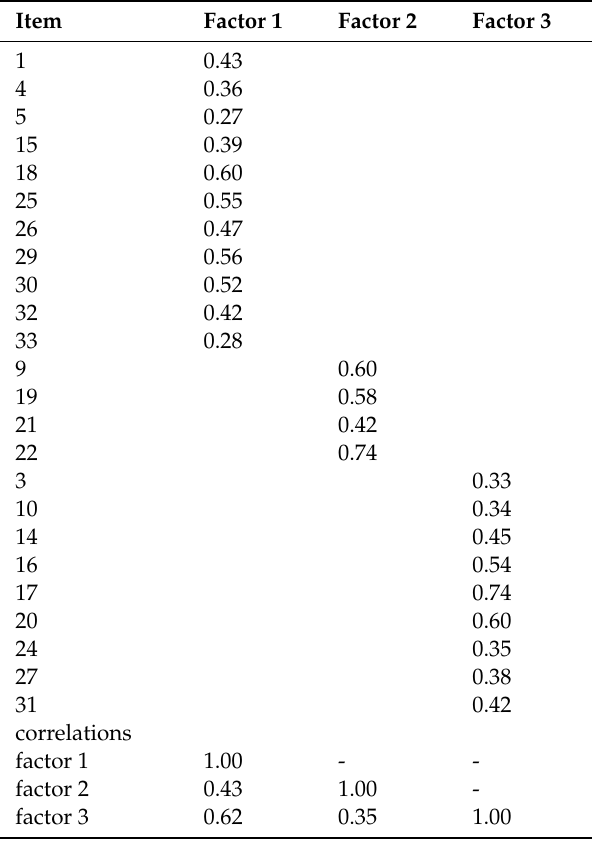
Table 1. Factor saturations and correlations between emotional intelligence factors (adapted from Grazzani et al., 2009 with permission). Item Factor 1 Factor